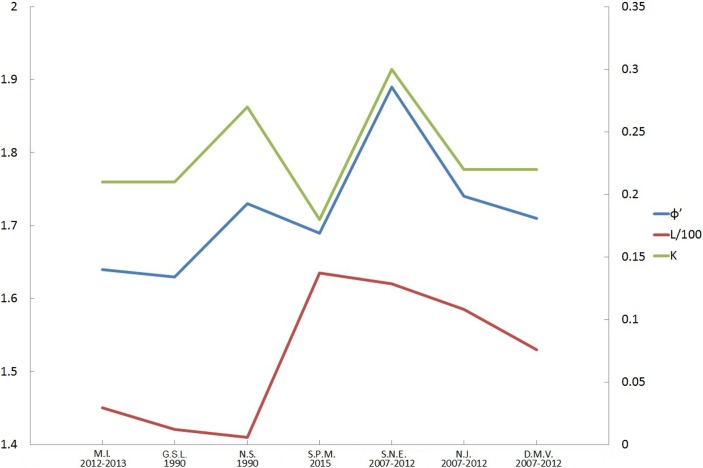
L∞/100, K and overall growth performance (ɸ’) calculated using the sVBGF parameters of the last study from each geographic zone (details in Table 1).